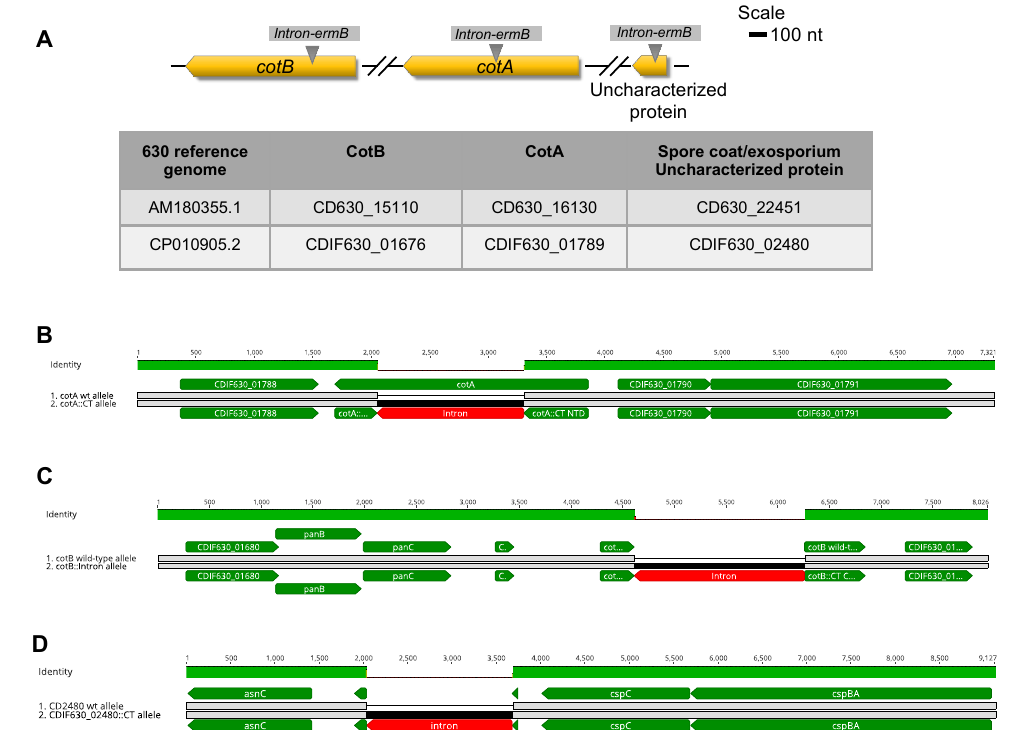
Figure 1. Analysis of cotA , cotB and CDIF630_02480 wildtype and intron-inactivated alleles. ( A ) Schematic representation of cotA , cotB and CDIF630_02480 loci in C. difficile 630. The table indicates the different codes used in both reference C. difficile 630 genomes. ( B – D ). Visualization of the pairwise alignment of the cotA ( B ), cotB ( C ) and CDIF630_02480 ( C ) loci derived from contigs that were de novo assembled with SPAdes, as described in the Methods and Materials section. Green coloring indicates C. difficile ORFs native to the loci of interest, whereas the red rectangle indicates the intron. Visualization was made using Geneious Prime software package.